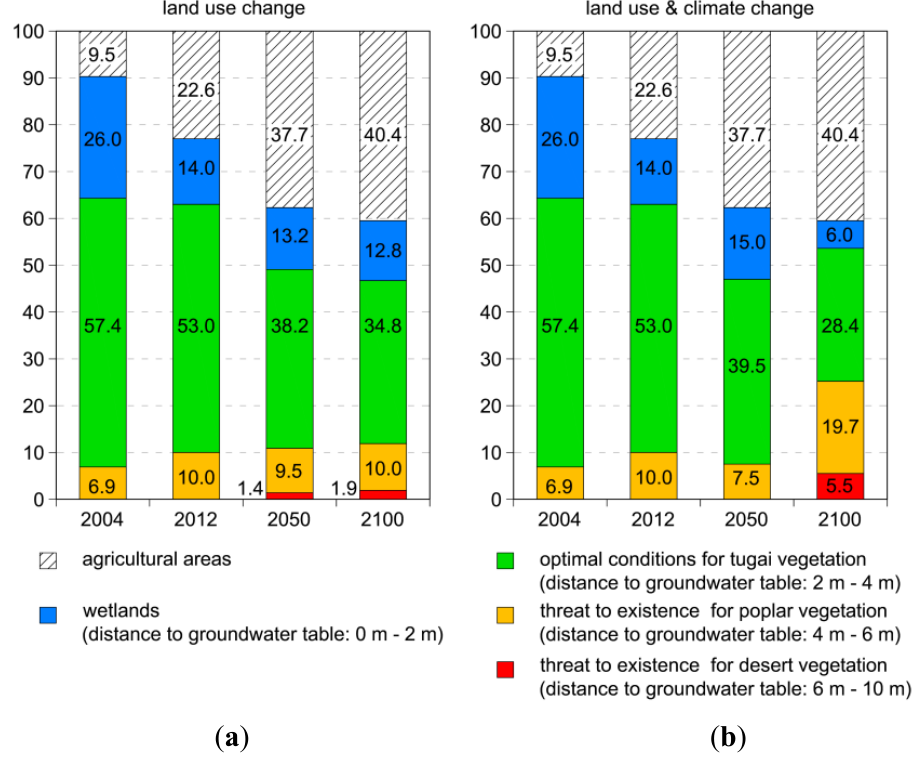
Figure 7. Changes in the vitality zones in future scenarios caused by ( a ) land-use changes and ( b ) land-use changes combined with climate